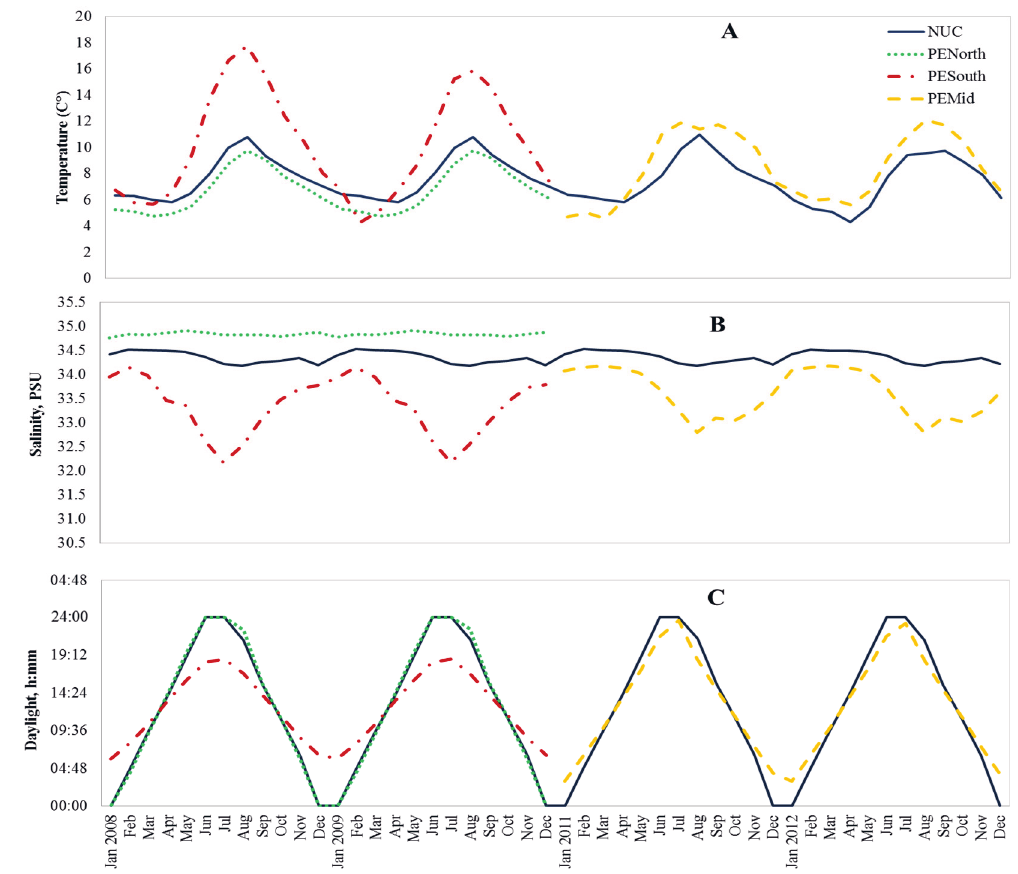
Figure 2. Environmental factors on the four farms: ( A ) average monthly sea surface temperature (degrees Celsius, °C); ( B ) average monthly salinity (practical salinity units, PSU); and ( C ) hours and minutes of day light (first day of the